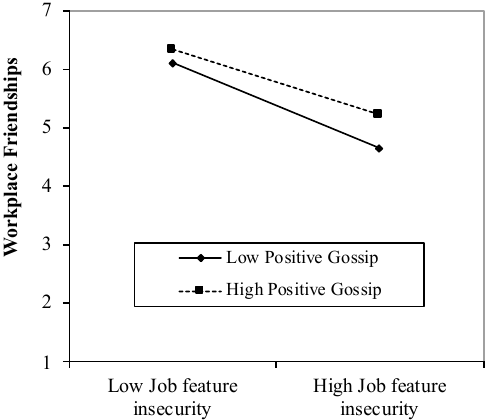
Figure 2. Buffering effect of the tendency to positive gossip on the negative relationship between job feature insecurity and workplace friendships.